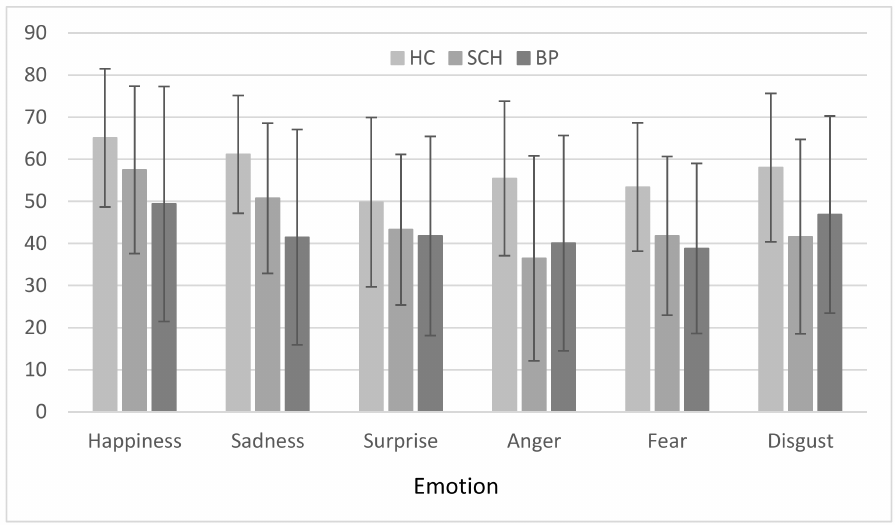
Figure 4. Mean scores on each emotion for each